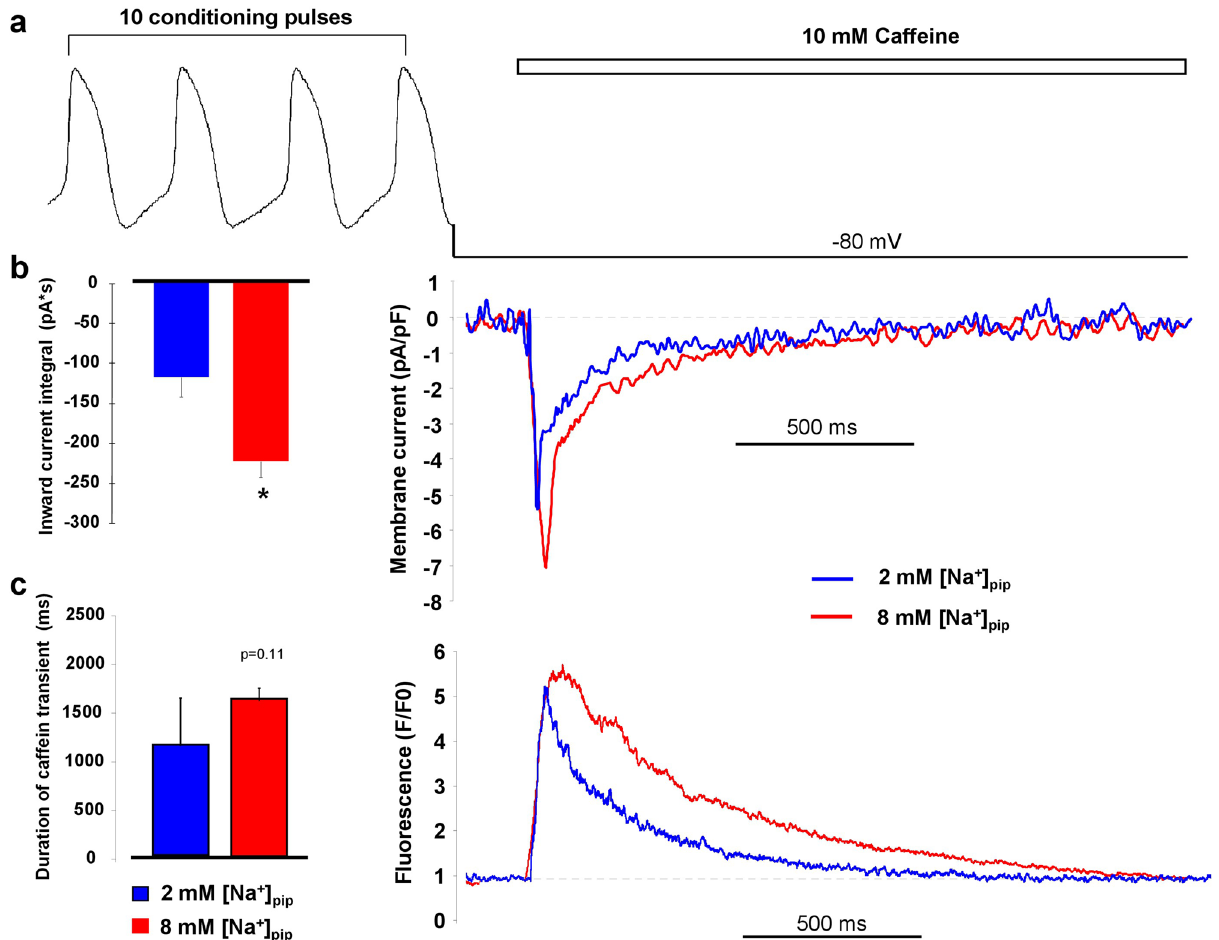
Figure 4. Measurement of the SR Ca 2+ content by rapid application of 10 mM caffeine. Caffeine was applied after 10 consecutive conditioning pulses to reach a steady-state load of the SR Ca 2+ content (panel a ). Panel ( b ) illustrates original caffeine induced inward current, while panel ( c ) illustrates the Ca 2+ transients in the presence of 2 (blue trace) and 8 mM (red trace) pipette Na + . We found larger SR Ca 2+ content in presence of 8 mM pipette Na + (independent t-test, panel b ). In contrast, we did not find statistically significant difference between the half- relaxation times of the Ca 2+ transients (independent t-test, panel c ). Data shown as mean ± SEM, n = 11 (panel b ) and n = 17 (panel c ), *means p <